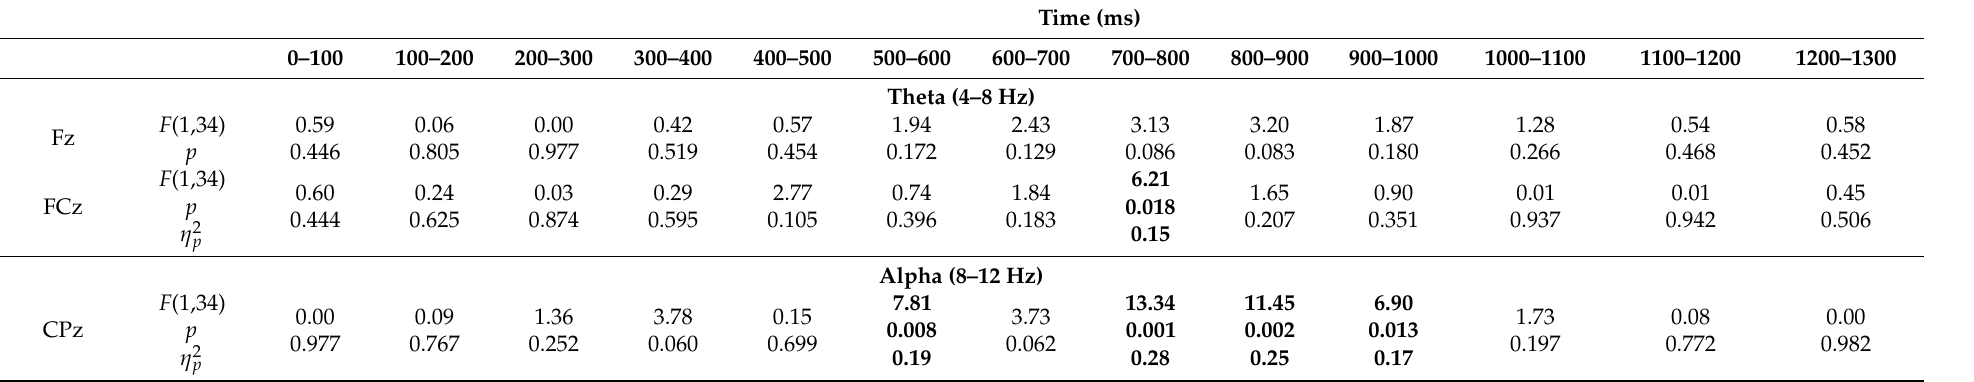
Table 4. Statistical Results for Main Effects of Value for Theta and Alpha Band Mean